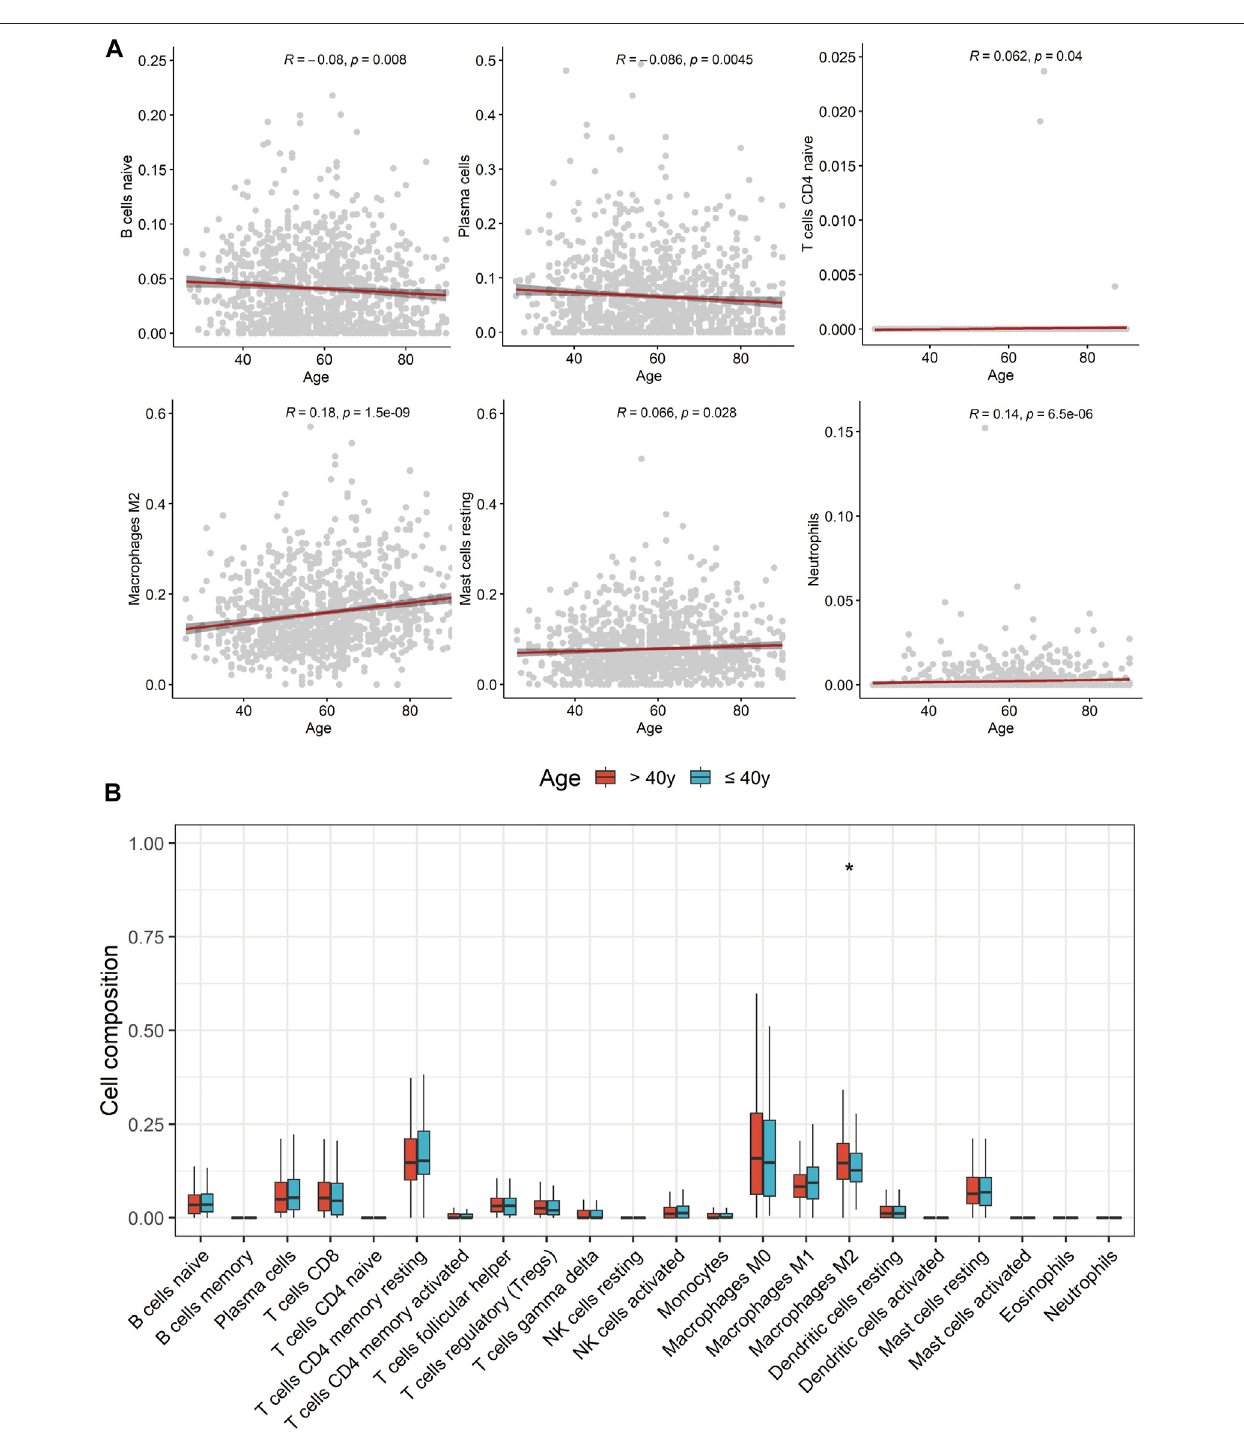
FIGURE 8 | Comparison of tumor immune in fi ltrating cell types in tumor microenvironment between young and non-young breast cancer samples. (A) Correlation scatter diagrams displaying correlation between age and several tumor immune in fi ltrating cell types. (B) Boxplots of the proportions of 22 immune in fi ltrating cells between two